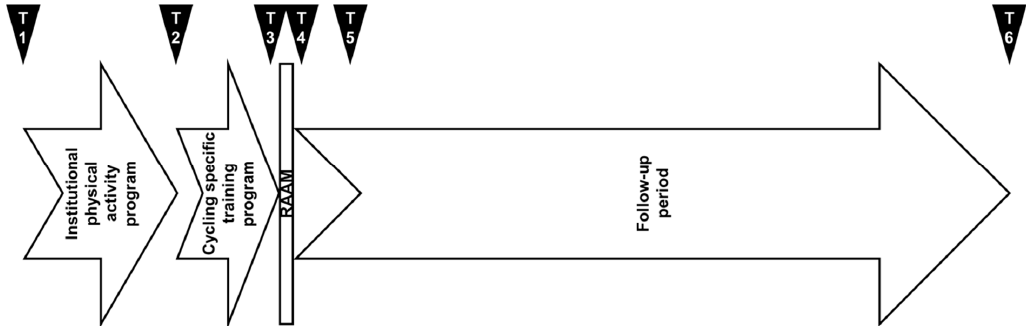
Figure 1. Four periods of the study, which was conducted during a 38-month period. Physiological and psychological health parameters were collected six times over the study period (T1–T6). Qualitative aspects were explored at